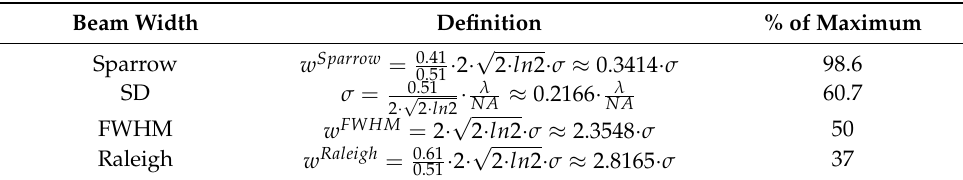
Table 6. Beam widths and associated intensities.